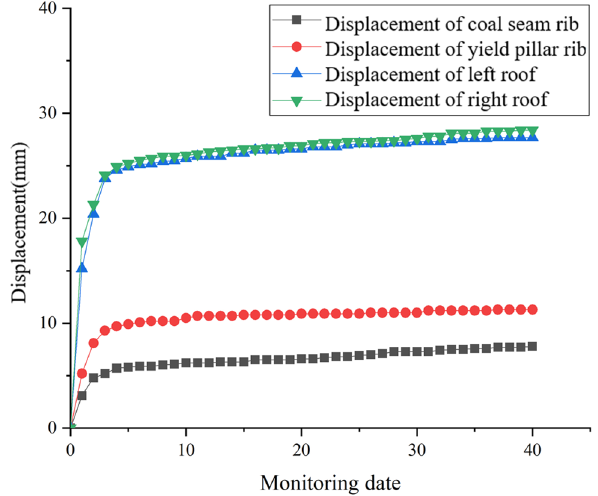
Figure 20. Yield monitoring of roof and two-side displacement data